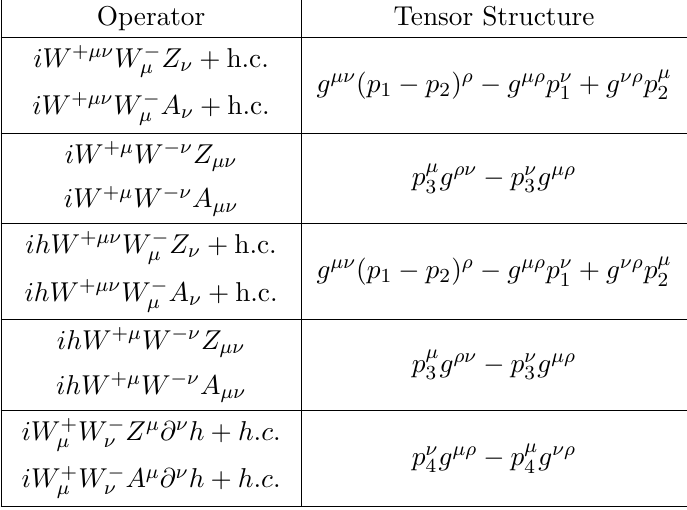
Table 5. The tensor structure of W + ( p 1 ; (cid:22) ) W (cid:0) ( p 2 ; (cid:23) ) V ( p 3 ; (cid:26) ) operators. The tensor structure of h ( p 4 ) W + ( p 1 ; (cid:22) ) W (cid:0) ( p 2 ; (cid:23) ) V ( p 3 ; (cid:26) ) operators.